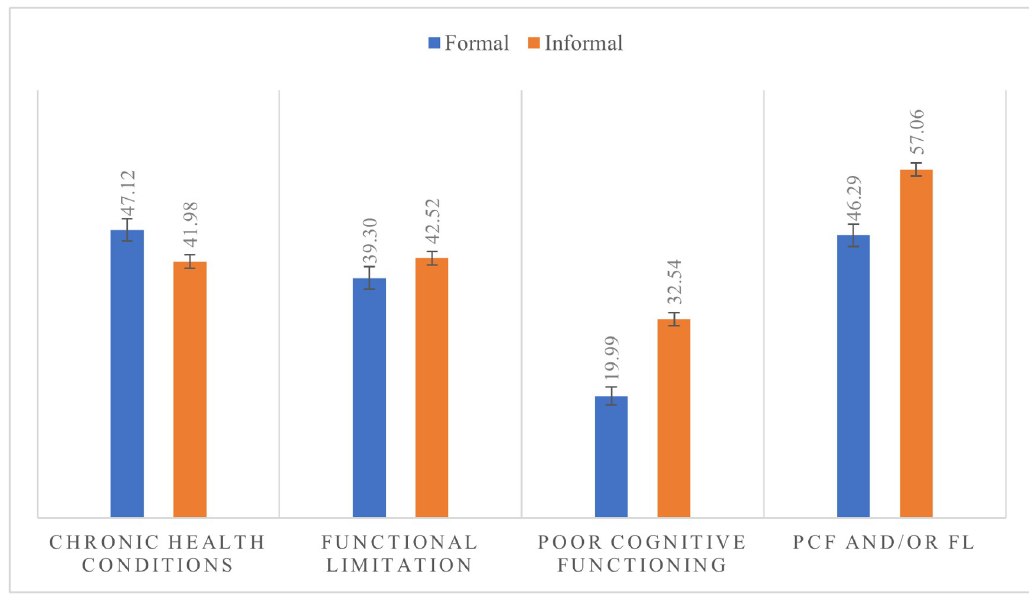
Fig 2. Level of health outcomes by type of